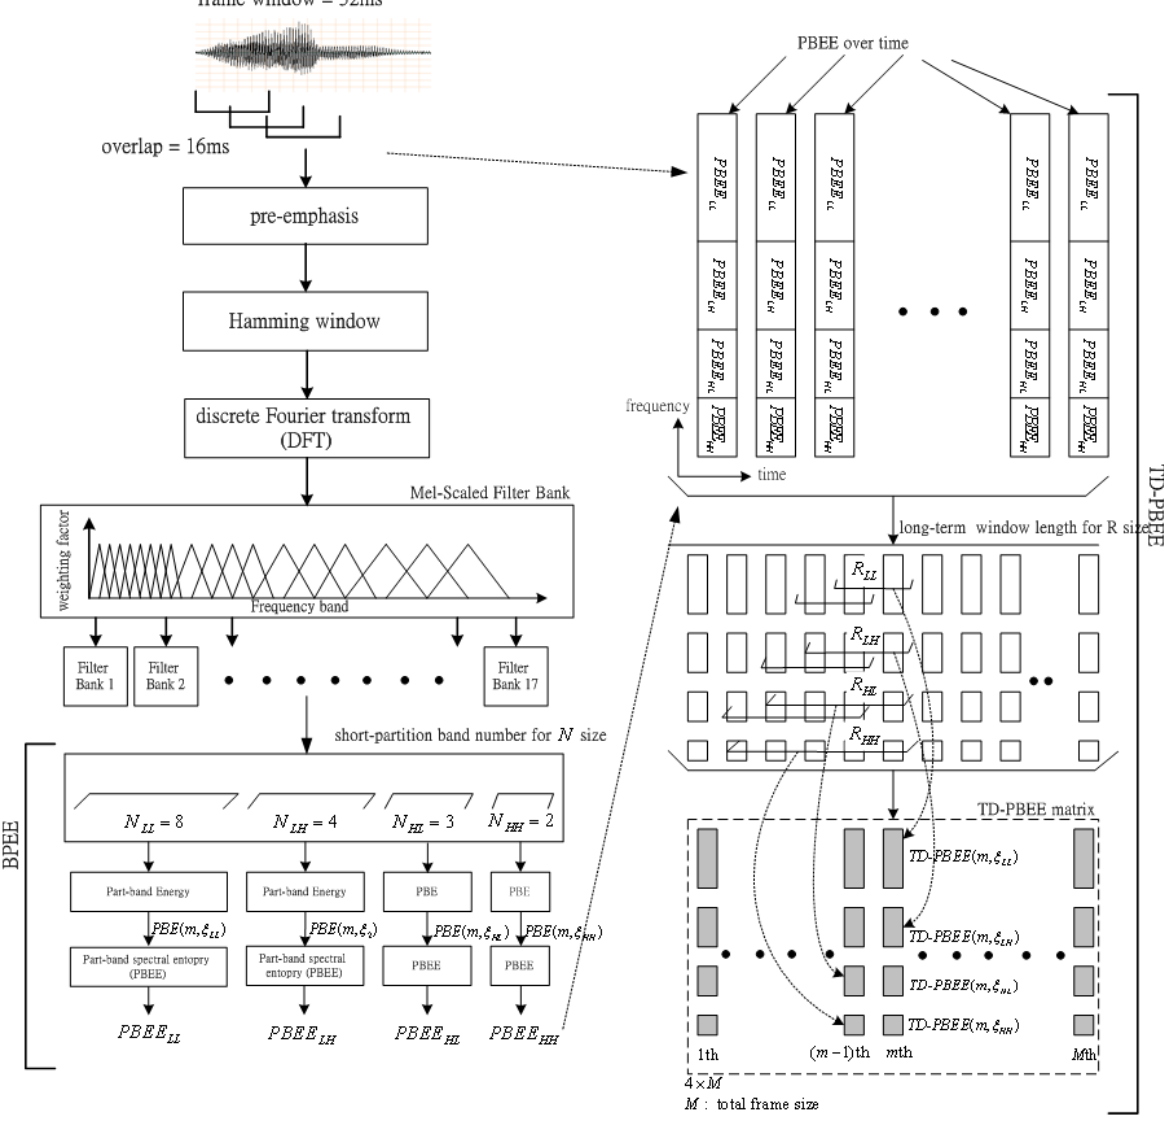
Figure 1. The block diagram of the feature extraction for TD-PBEE